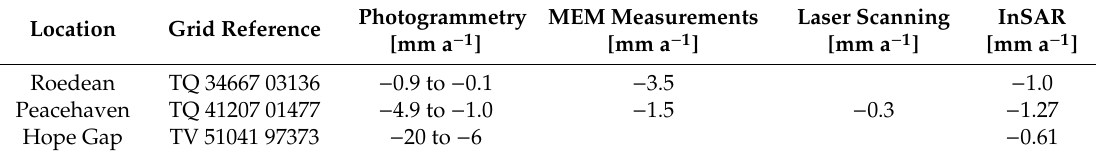
Table 3. Surface erosion comparison between di ff erent measurement methods, updated with the results from the processing of InSAR data. Previous data table collated in Dornbusch and Robinson [42]. It should be noted that the exact position of the terrestrial measurement methods is not